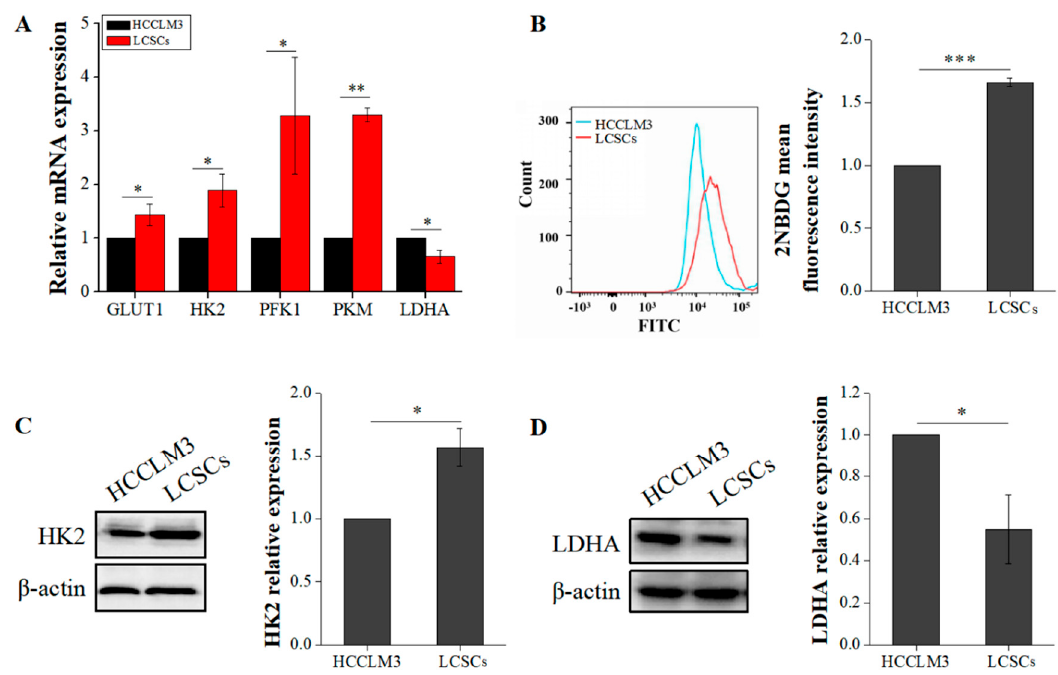
Figure 2. Comparison of glycolysis between HCCLM3 and LCSCs. ( A ) Comparison of glycolytic genes. ( B ) Comparison of 2-deoxy-2-[(7-nitro-2,1,3-benzoxadiazol-4-yl) amino]-D-glucose (2-NBDG) uptake. ( C ) Comparison of the glycolytic protein hexokinase 2 (HK2). ( D ) Comparison of the glycolytic protein lactate dehydrogenase A (LDHA). The values are presented as the means ± SD of three independent experiments. n = 3; * p < 0.05; ** p < 0.01; and *** p < 0.001.